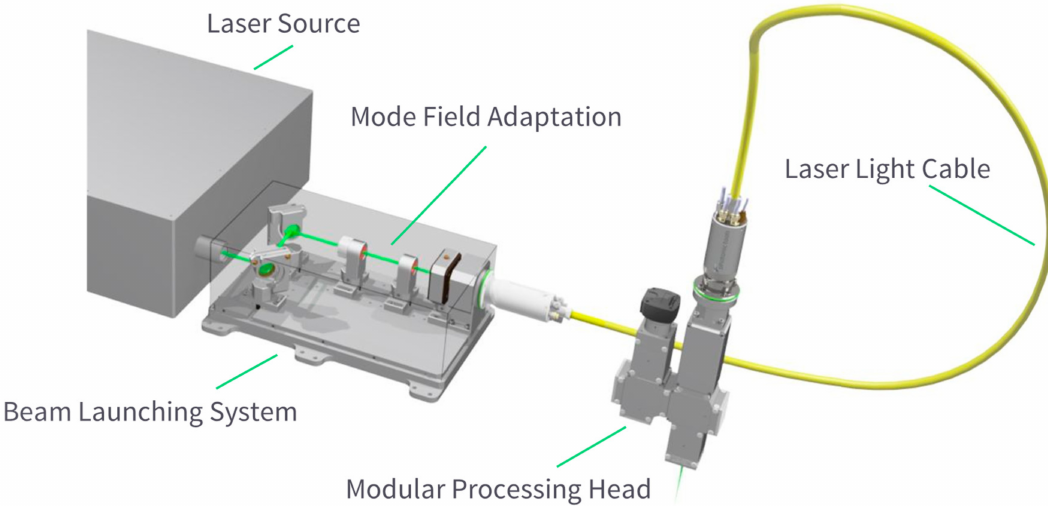
Figure 5. Ultrafast beam delivery system with a beam launching system (BLS) composed of a mode field adaptation, a laser light cable (LLK) and a modular processing head